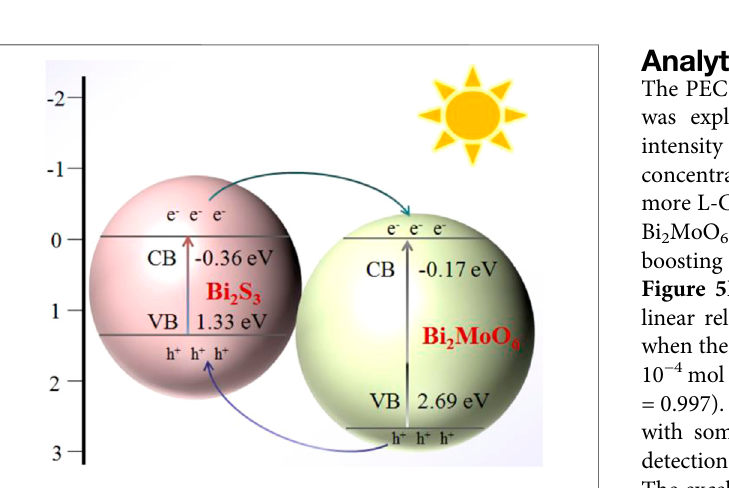
SCHEME 2 | Charge transfer of Bi 2 MoO 6 – Bi 2 S 3 under visible light